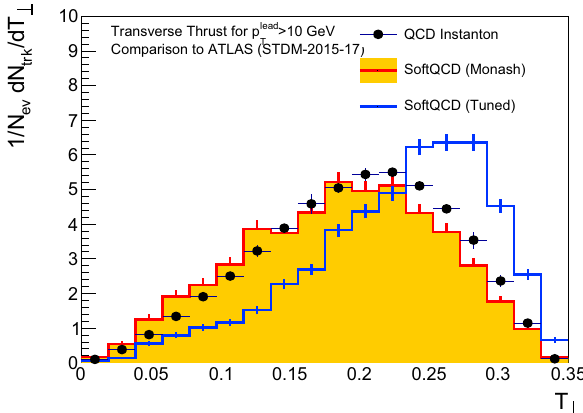
Fig. 21 Expected exclusion limits at 95% CL on the cross section for Instanton induced processes for three different assumed integrated luminosities . Conservative systematic uncertainties on the background modelling have been made.